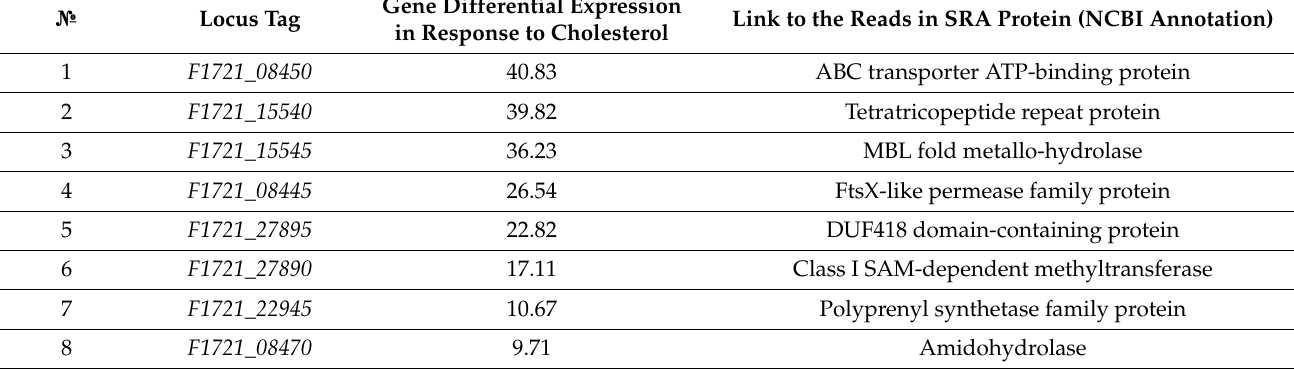
Table 2. Genes of S. hirsuta whose expression increased in response to induction with cholesterol at 24